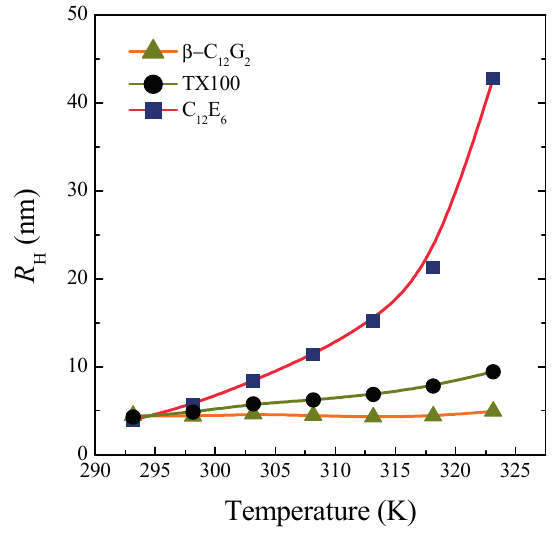
Figure 6. Apparent hydrodynamic radius of micelles, R H , as a function of